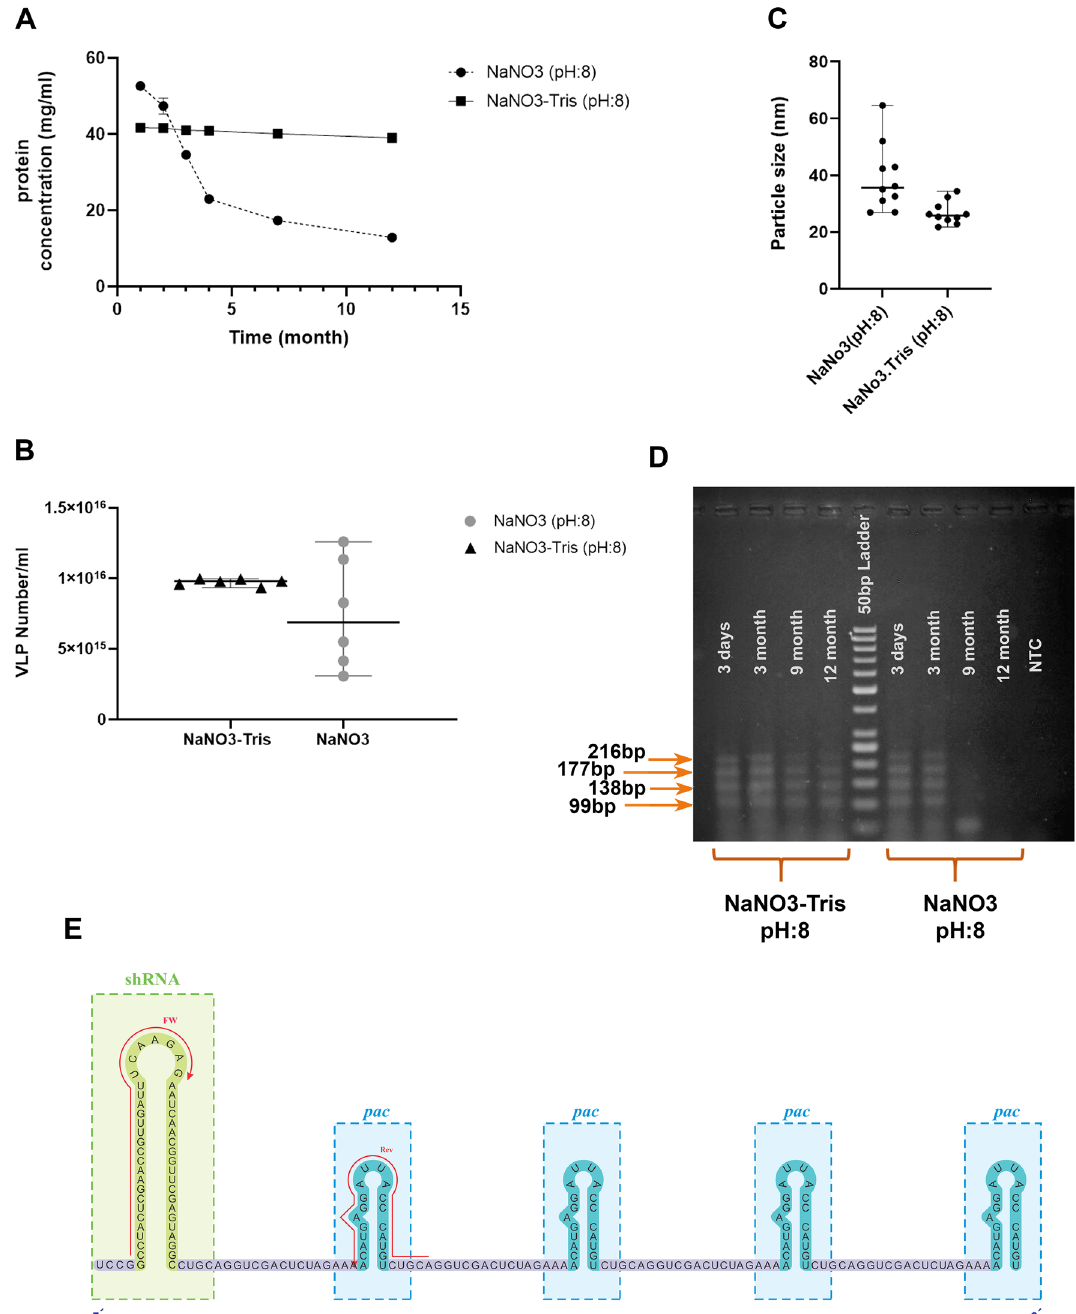
Figure 4. VLPs produced in the NaNO3-Tris were more stable than VLPs produced in the NaNO3 solution. ( a ) Protein concentration evaluation of VLP suspension in two buffers. The amount of protein was reported as mg ml-1. ( b ) Number of VLPs in 1 ml VLP suspension according to the protein concentration. The values are from repeated measurements of samples through 12 months. ( c ) The scattered plot of VLP size in NaNO3 solution and NaNO3-Tris buffer (100 mM NaNO3 and pH: 8, for both of them). The size was analyzed 10 times in each sample and was shown as median with range. ( d ) Gel electrophoresis for RT-PCR fragments (99, 138, 177, and 216 bp); RT-PCR fragments of RNA extracted from VLPs in NaNO3-Tris (pH: 8)- left, and VLPs in NaNO3 (pH: 8)- right, after 3dyas, 3, 9, and 12 months. ( e ) The sequence of shRNA and four hairpins ( pac sites) was packed in MS2 VLPs. Primer locations were shown as Fw and Rev on the sequence. The stability of VLPs and their ability to protect the inner shRNA was checked by RNA extraction and